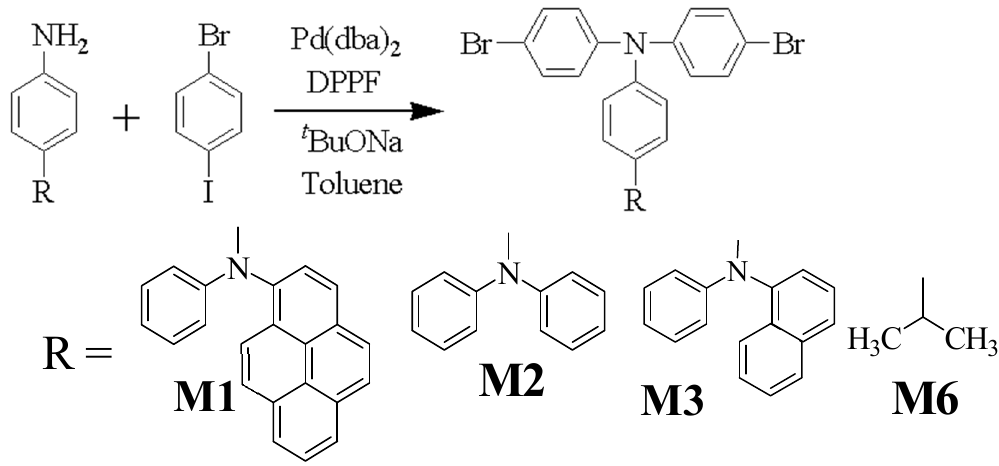
Figure 1. The Buchwald–Hartwig amination process was used to produce M1, M2, M3, and M6.